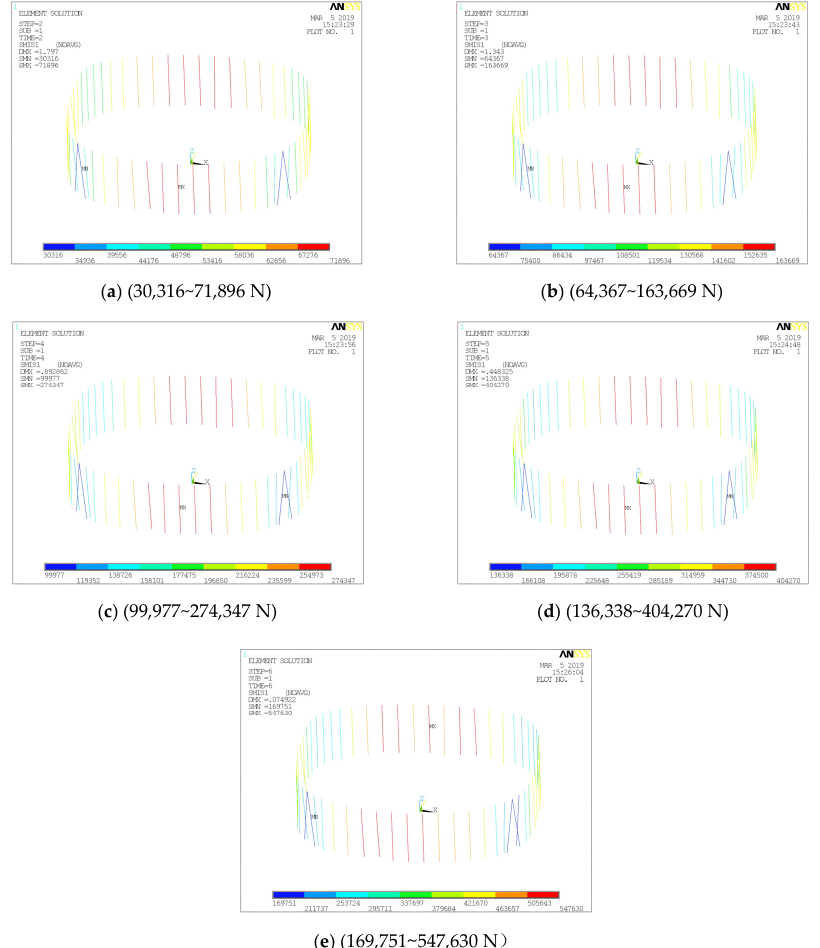
Figure 38. Tie-down force nephograms (N): ( a ) C2, ( b ) C3 ( c ) C4, ( d ) C5, ( e ) C6. When synchronous equal proportion tension is adopted, the maximum CR radial de- formation of 144 mm, which occurs at the short axis (axis 15), is still unsatisfactory. After the lifting is completed, the expansion of the short axis of the CR is basically large due to the analysis in Section 4.2.1. At the initial stage of synchronous equal propor- tional tension of the tie-downs, the changes in cable force in the cable net make the forces acted on the CR more uneven, and its uneven deformation further expands, resulting in more obvious outward expansion at the short axis. Therefore, the adjusting objective is set as: reduce radial deformation of the CR. The tie-down tension strategy is adjusted to proportional section tension according to the outward expansion degree of the CR. The initial tension proportion of the tie-downs at the short axis should be larger than that at the long axis and 45° angle, so as to control the outward expansion deformation at the short axis. Results of Proportional Section Tension According to the adjusted tension idea obtained from the analysis in the previous section, the tie-downs are divided into three areas: A, B, and C, as shown in Figure 39.